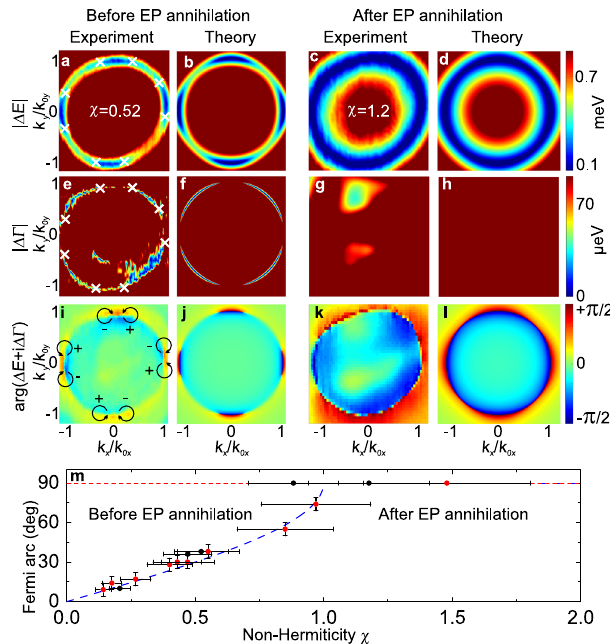
Fig. 4 | Observation of EPs, of their topological charges and of their annihila- tion. Theoretical fi gures are obtained by diagonalizing the Hamiltonian (2) with parameters obtained from the sample 1 and given in Methods. The procedure for the extraction of experimental energies is detailed in Methods. a – d Difference of therealpartoftheeigenenergiesfor2 Δ =3meV( a , b )and1.2meV( c , d ).Thecolor bar is saturated above 0.9meV. The white crosses in ( a ) show the EP coordinates limiting the blue area corresponding to real Fermi arcs. e – h same as ( a – d ), but for imaginary part. The color bar is saturated above 90 μ eV. Imaginary Fermi arcs appear in blue. i , k Experimental and ( j , l ) theoretical phase (argument) of the difference of complex energies. EPs are associated to a vortex phase with a phase shift± π whosewindingisshownbythearrowsin( i ). m LengthoftheFermiarcwith respect to non-Hermiticity. Black, red points – experiments with sample 1,2 respectively(seeMethods),blueline – theory.ThemaximallengthofeachFermiarc (90 ∘ ) is marked with a thin red line. Error bars indicate the measurement uncer- tainty.Theexperimentalpointsareobtainedbyvaryingthenon-Hermiticitydegree χ (controlled by the detuning Δ via applied voltage V